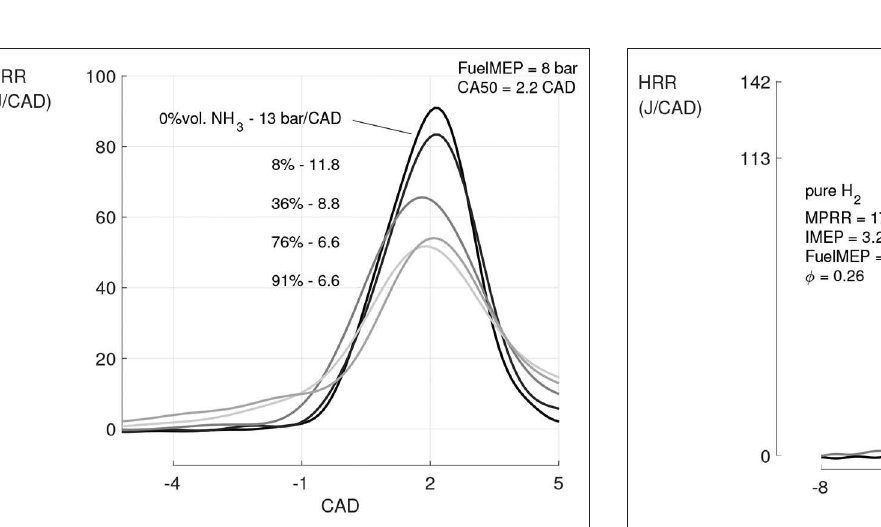
FIGURE 10 | For equivalent MPRR and combustion timings, ammonia possesses a much longer initiation period than hydrogen, during which some heat is released but too few to trigger the bulk auto-ignition (set #3). The CA10, CA50, and CA90 are marked by squares on the HRR curves. For equivalent ignition timings and combustion durations, ammonia allows to increase the IMEP by more than 50% without impacting the indicated